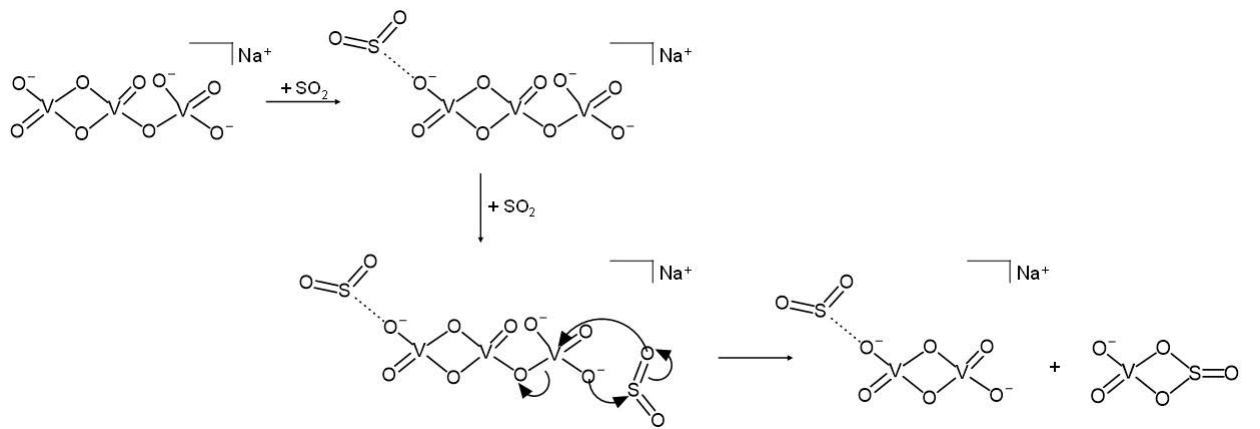
Scheme 2. Plausible reaction mechanism of NaV 3 O 92 − ions with SO 2 based on the corresponding kinetic